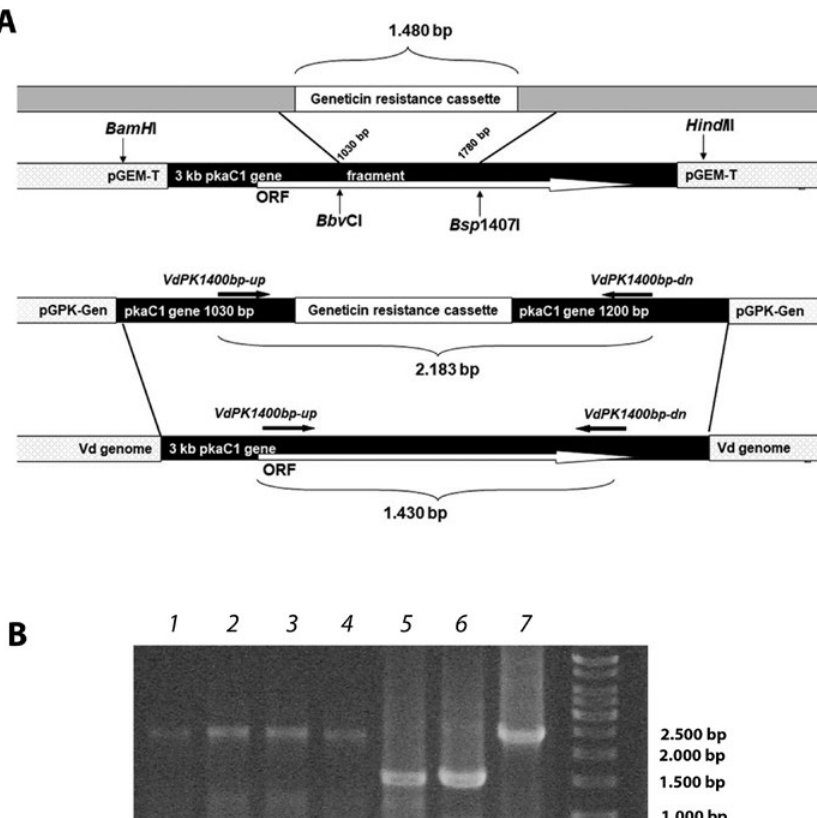
Figure 1. Generation of Verticillium dahliae pka C1/ veg B double disruption mutants. A) Schematic presentation of pka C1 mutant allele con- struction and integration in the fungal genome by a double homologous recombination event. B) Disruption of pka C1 verified by amplifica- tion of the gene from four double disruptants 123Δ VP1, 123Δ VP2, 123Δ VP3, and 123Δ VP4 (lanes 1-4; 2.183 bp), genomic DNA (lane 5) and plasmid DNA (lane 6) of clone pPKA3kb, with native fragment 1430 bp), and plasmid DNA of clone pGPK-Gen (lane